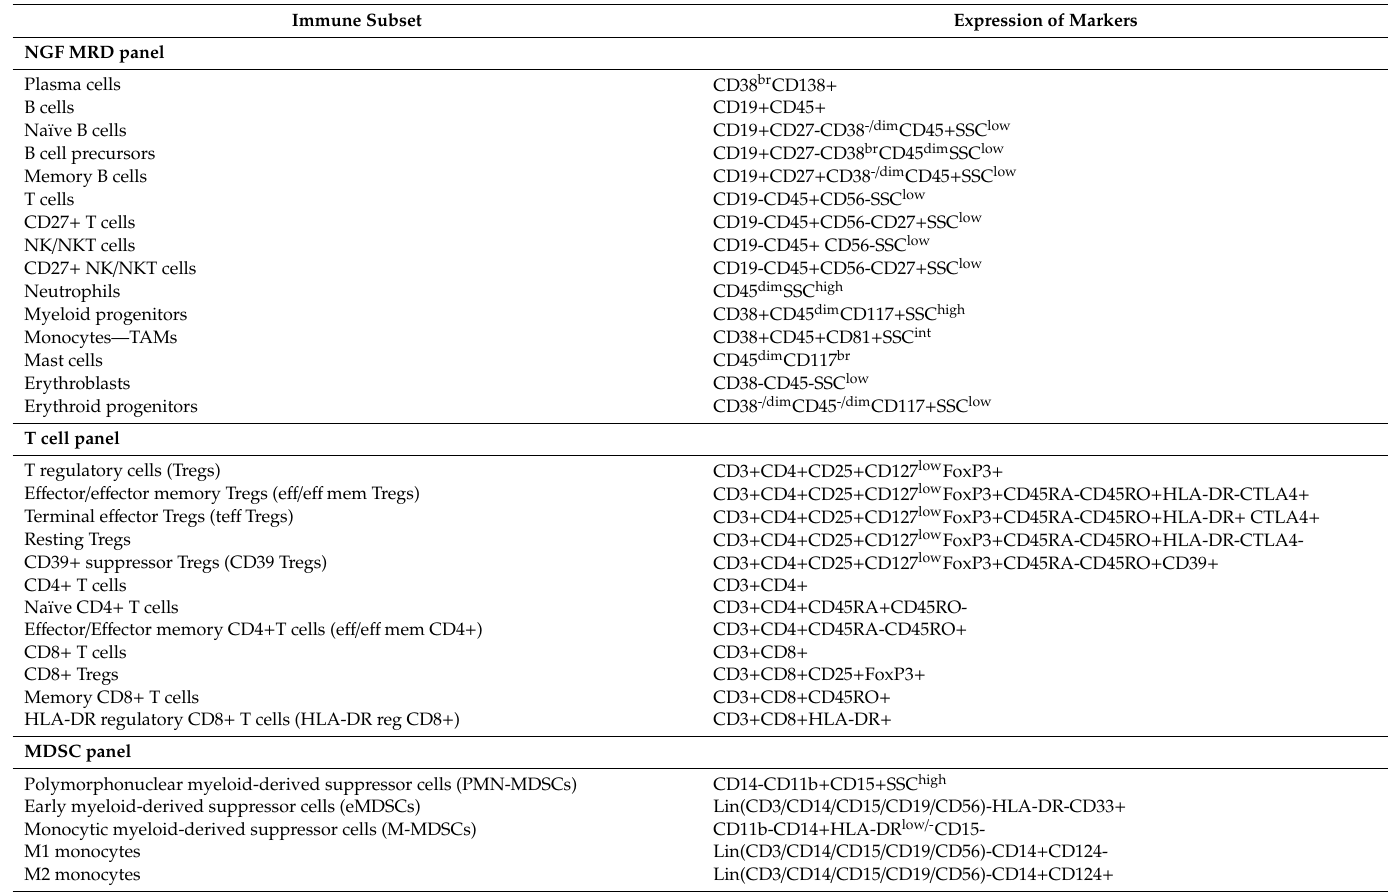
Table 2. Immune subsets and their corresponding phenotypes analyzed in bone marrow (BM) and peripheral blood (PB)